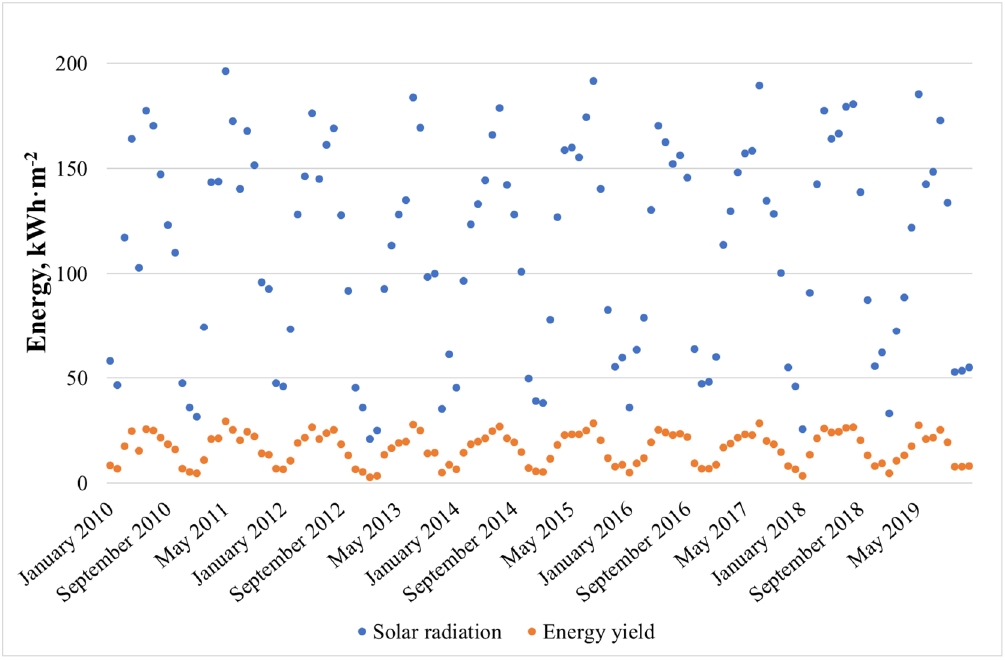
Figure 5. Solar radiation and PV system energy yield.